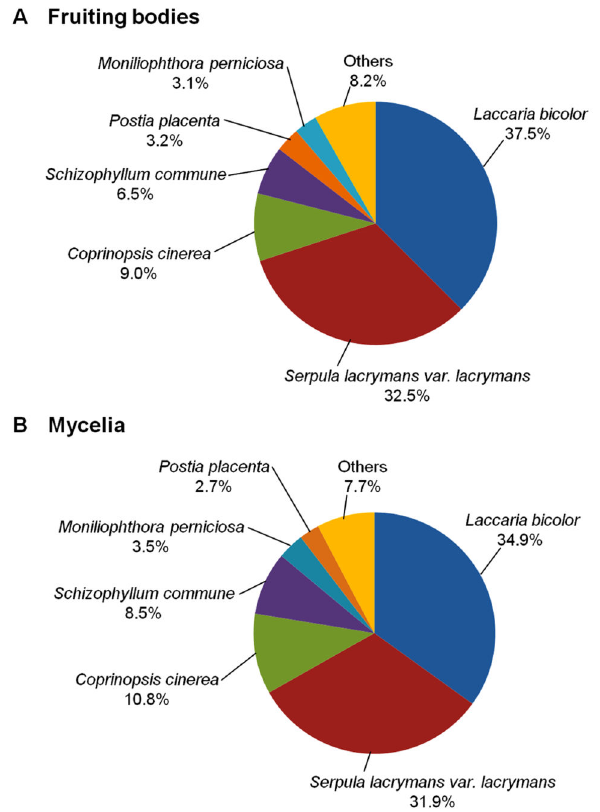
Figure 1. The frequency distributions of species having the significantly homologous sequence with P. porrigens . Species distributions of the top BLASTX hits for unigene sets in (A) fruiting bodies and (B) mycelia. doi: